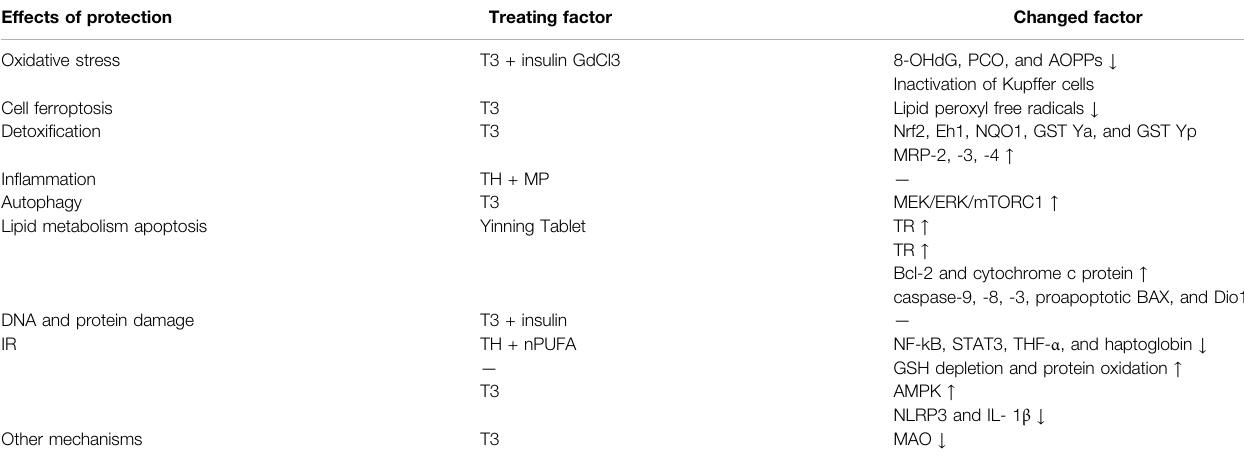
TABLE 2 | Regulatory mechanism of the TH/TR axis alleviates acute liver injury. The regulatory mechanisms are clari fi ed into three categories, including the effects of protection or exacerbation, treating factors, and changed factors. TH downregulates 8-OHdG, PCO, and AOPP levels. TH can also synergize with MP to improve oxidative stress and liver damage and realize anti-in fl ammatory and antioxidant effects. T3 scavenges lipid peroxyl free radicals and improves cell. The combined supplementationofT3andn-3PUFA wasgiventoratstodecrease IRliverinjuryand oxidative stress.T3treatment recovers NF- κ Bactivity, STAT3,TNF- α ,andhaptoglobin and increases liver GSH depletion and protein oxidation protection against IR. T3 upregulates the liver redox-sensitive nuclear transcription factor Nrf2 DNA, detoxi fi cation, and drug transport proteins expression,especially including protein levels ofEh1, NQO1, GST Ya, GST Yp,MRP-2, MRP-3, and MRP-4. Theinactivation of Kupffer cell by GdCl3 can suppress T3-induced oxidative stress, thus ameliorating the development of liver injury. T3 induces liver PC against IR supported by triggering AMPK, ultimately accelerating the depletion of in fl ammatory factors such as hepatic NLRP3 and IL-1 β . T3 induces hepatocyte proliferation in toxic liver injury. T3 injection protects liver IR damage by enhancing MEK/ERK/mTORC1 mediated autophagy. TH-induced MAO inhibitors inhibit the activity of MAO protecting against liver injury. The accumulation of TR mRNA may remove negative in fl uences in fl uoride-related liver injury via preventing disruption of lipid metabolism, oxidative